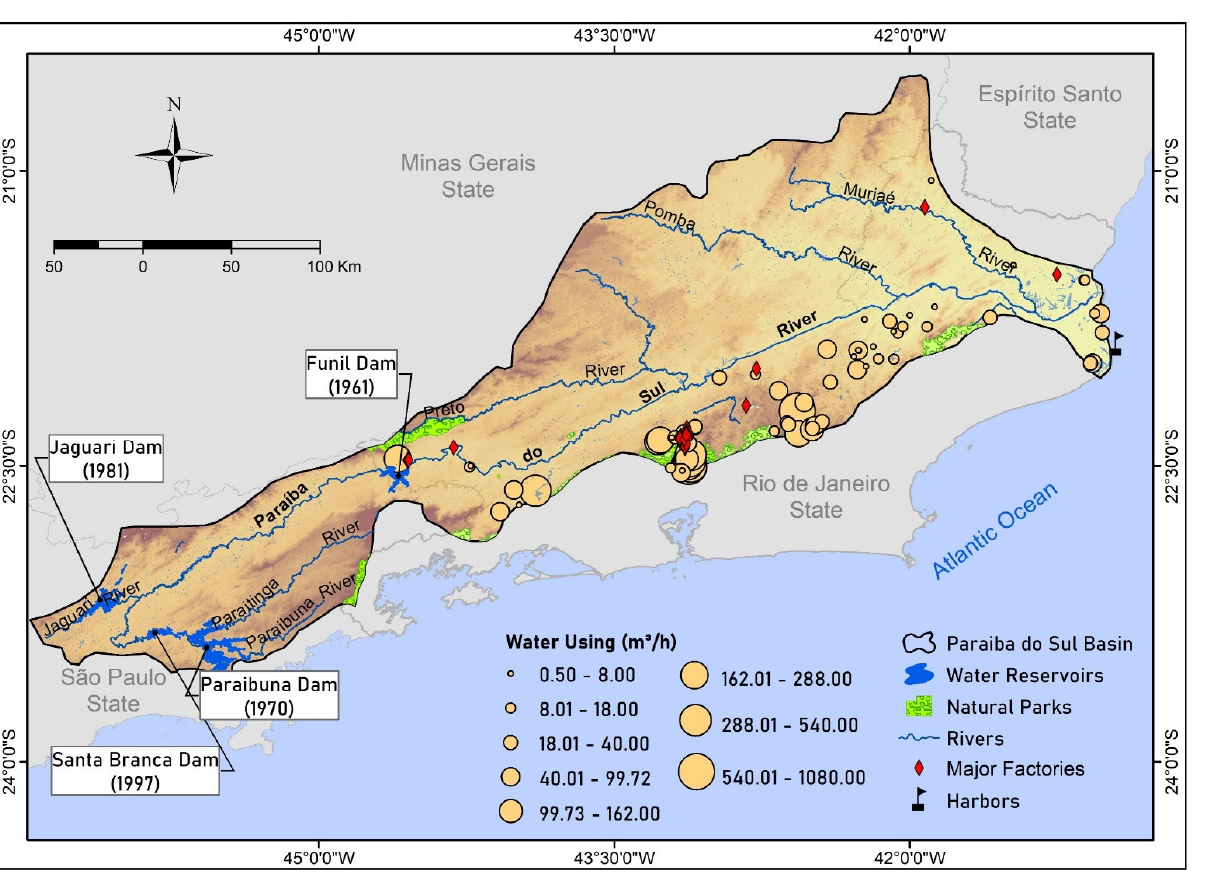
Figure 3. Anthropization map of the hydrographic basin. The number below the name of each dam represents the year in which it started to operate. Sources: [65,69,95]. Coordinate System: UTM. Datum: SIRGAS, 2000.